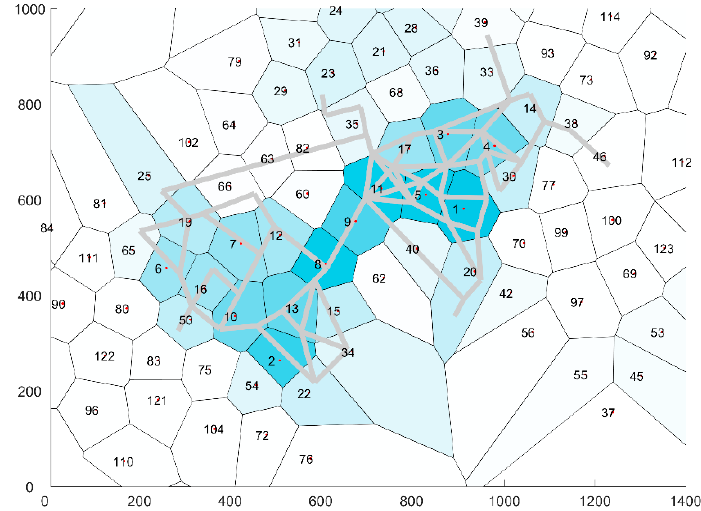
Figure 2. Number of hits per cell distributed over the area, where the grey lines identify the network of the Mysteryland festival area in 2017. Darker coloring of the cells represents a higher number of hits.